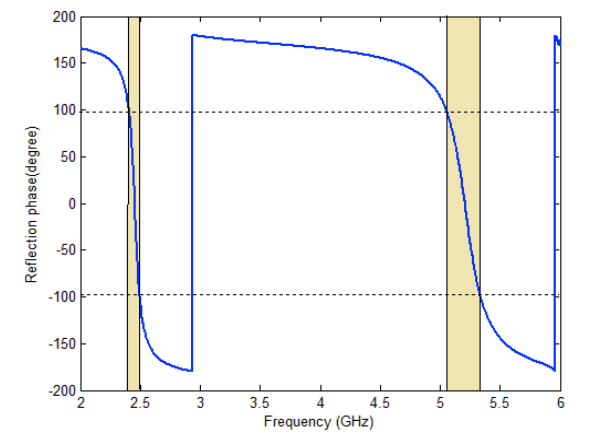
Fig. 7. Reflection phase response for proposed AMC structure.